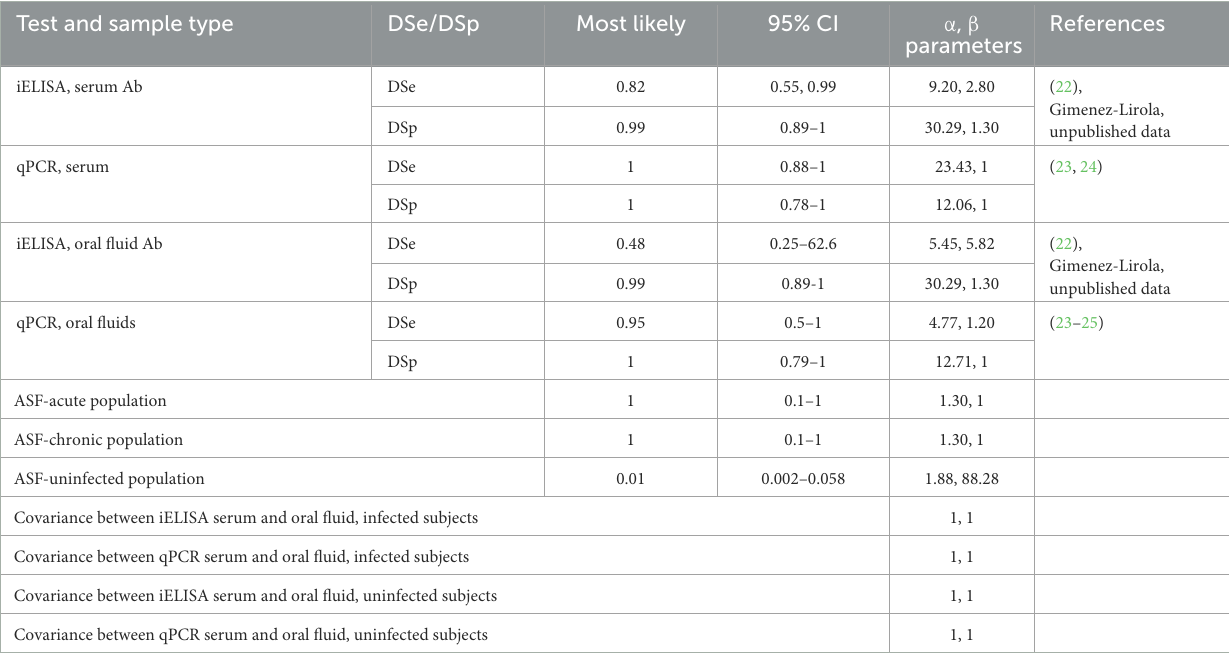
TABLE 2 Values and sources of priors used for BLCA